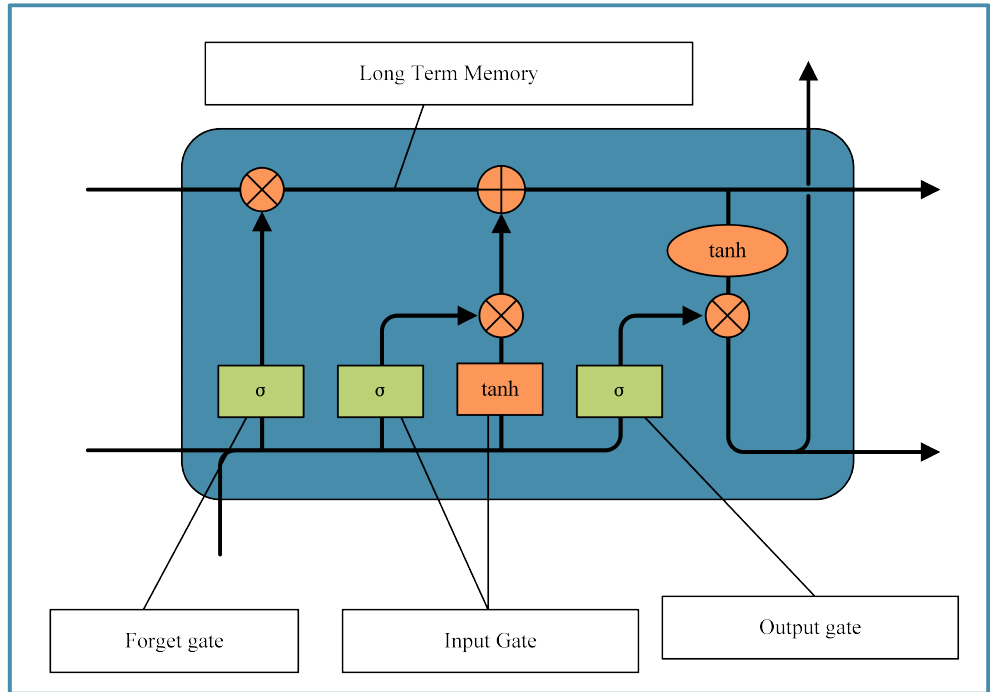
Figure 4. The internal structure of LSTM